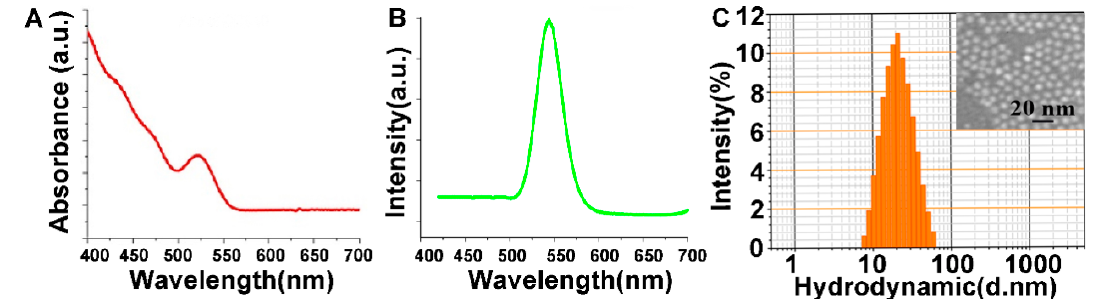
Figure 1. Characterization of CdSe/ZnS quantum dots (QDs). ( A ) absorption; and ( B ) emission spectra of CdSe/ZnS QDs; ( C ) the diameter of CdSe/ZnS QDs determined by dynamic light scattering (DLS) and Transmission electron microscopy (TEM).